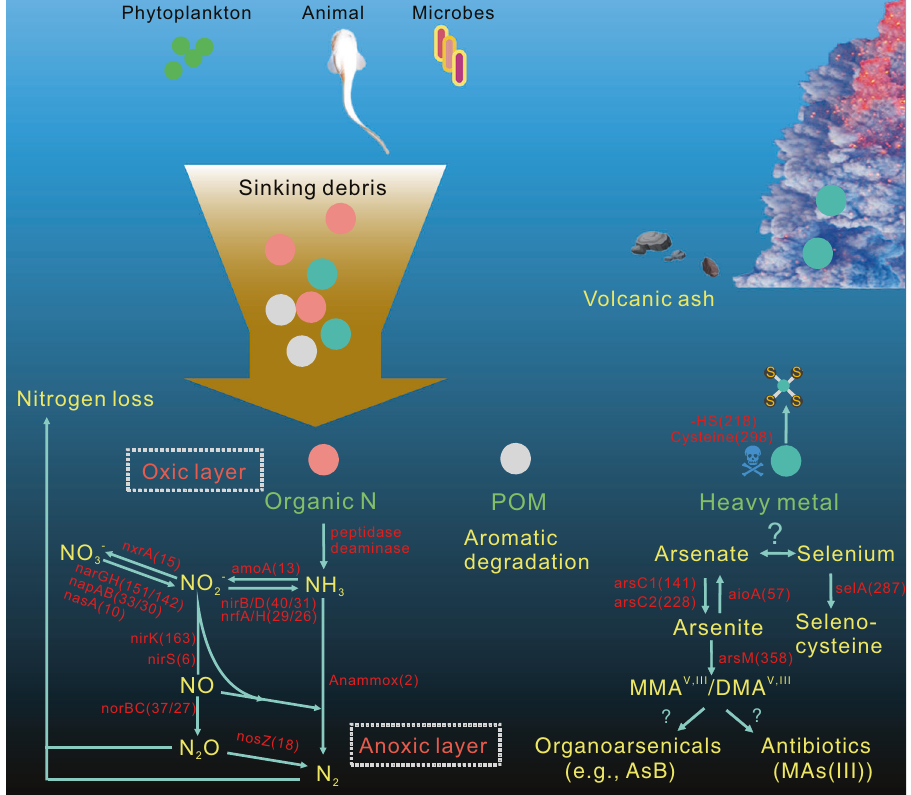
Fig. 5 Schematic representation of potential nitrogen and arsenic cycling in bottom-axis CD sediments. The number of genomes that contain the genes involved in nitrogen and arsenic cycling steps is in parentheses. Source data can be found in Supplementary Data